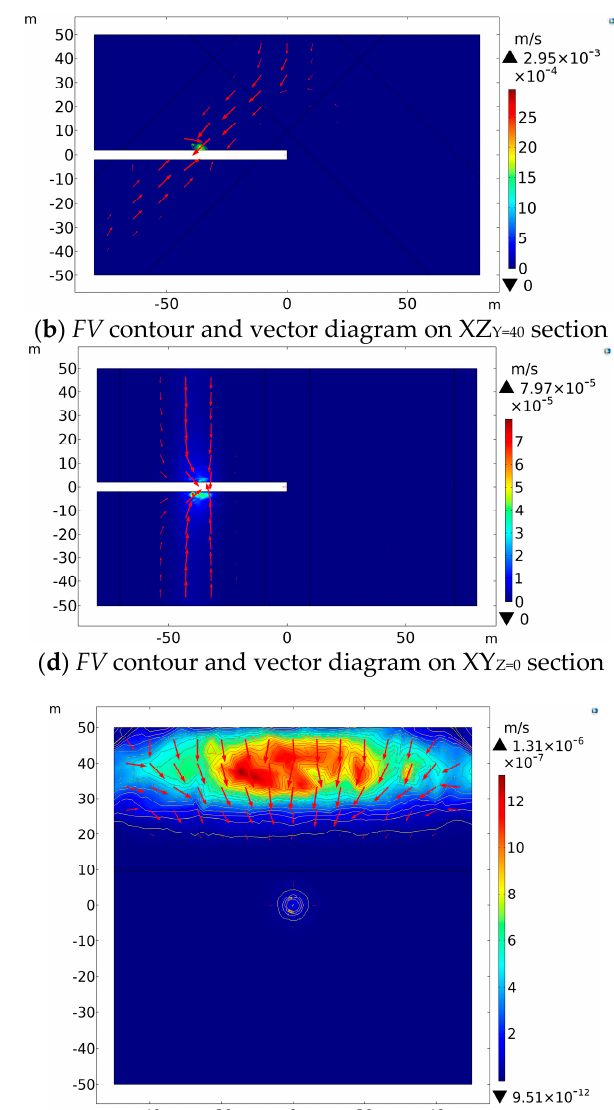
( d ) FV contour and vector diagram on XY Z=0 section